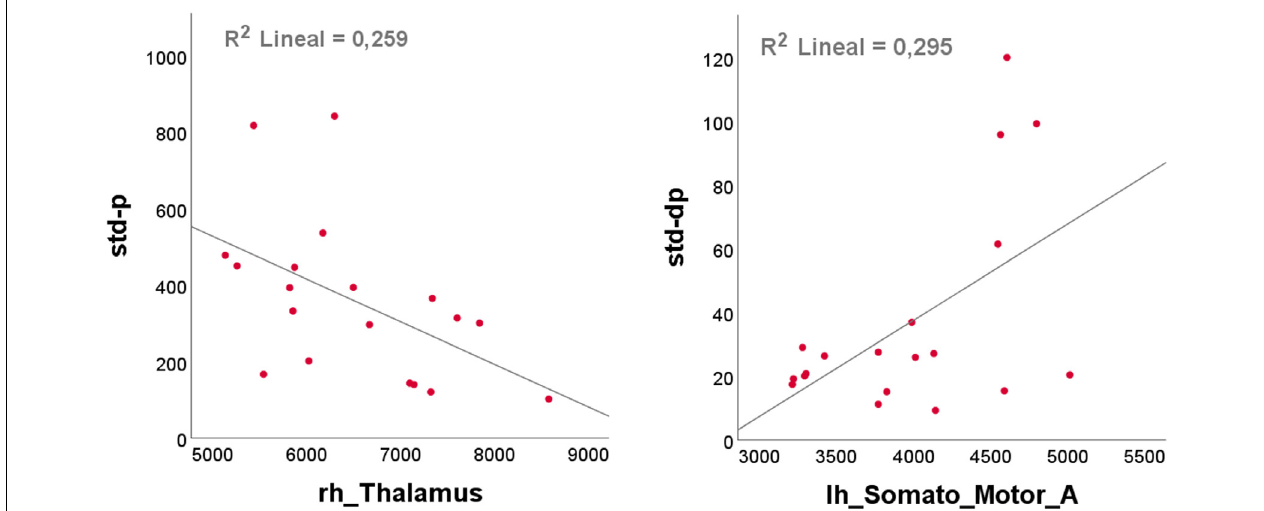
FIGURE 7 | Scatterplots of handwriting features against neuroimaging biomarkers with the best linear line fit, determined using ordinary least squares (OLS, SPSS): (left) std of pressure and rh_Thalamus; (right) std of pressure variation and lh_Somato_Motor_A, a network in the